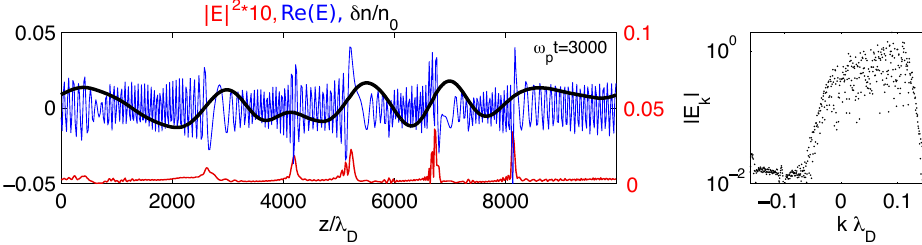
Figure 1. Langmuir wave packet at time ω p t = 3000 in a inhomogeneous plasma with ∆ n (cid:39) 0.01. ( Left panel): Spatial profiles along the coordinate z / λ D of the electric field envelope Re ( E ) (blue), the density fluctuations δ n / n 0 (black) and the turbulence level | E | 2 × 10 (red). ( Right panel): Corresponding electric field spectrum | E k | in logarithmic scales, as a function of the normalized wave number k λ D . No beam is present. All variables are normalized. (Reproduced by permission of the AAS